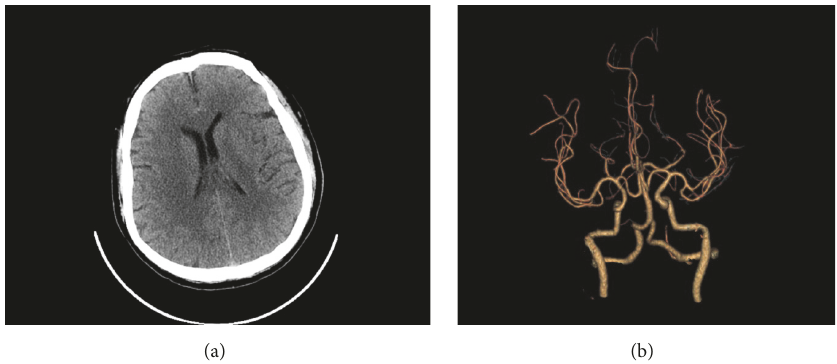
Figure 1: Initially, (a) a noncontrast computed tomography (CT) and (b) a computed tomography angiography (CTA) of the head performed on at the time of the admission showed no abnormalities and vascular malformations.